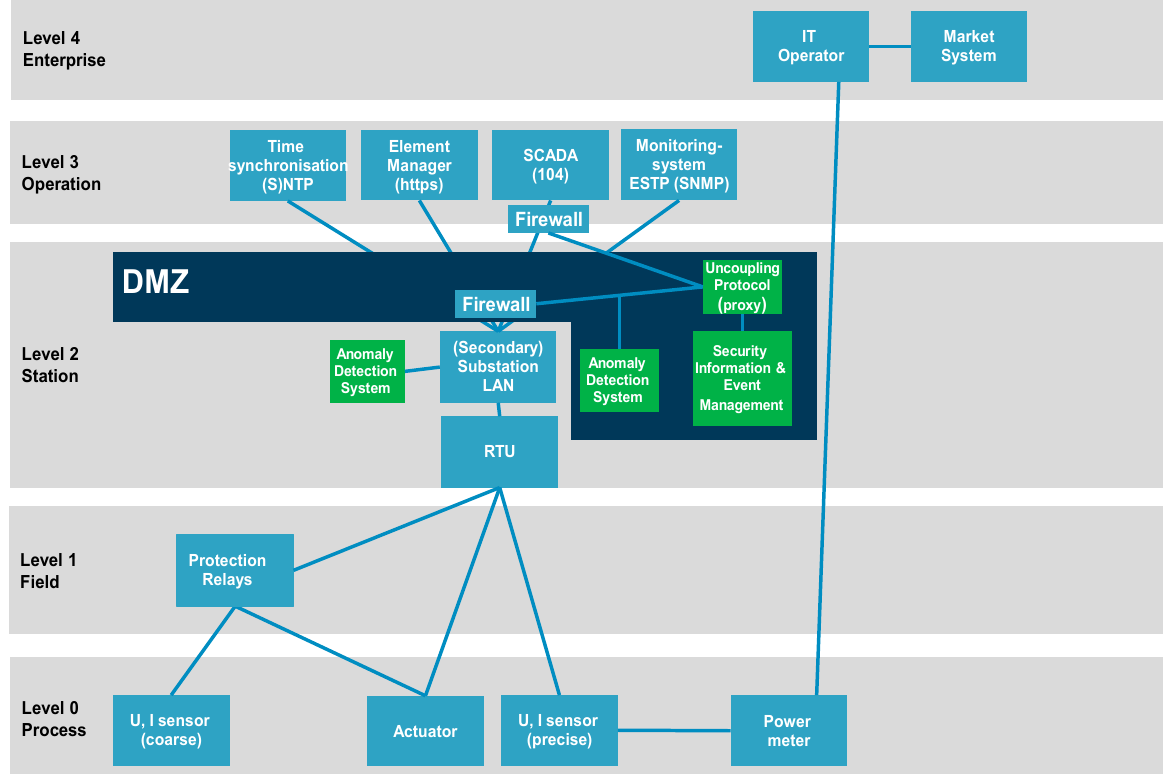
Figure 3. Smart Grid overview.